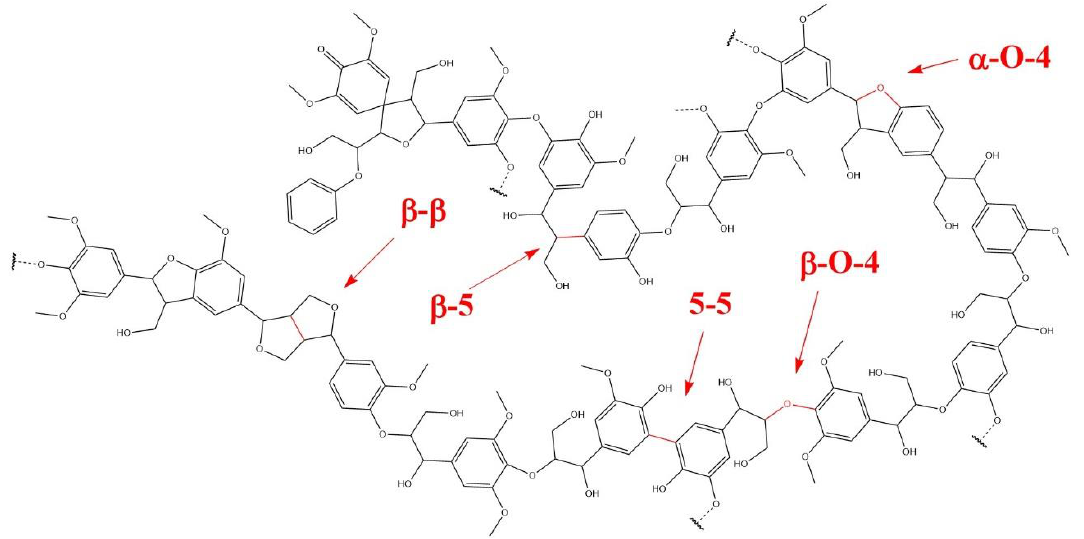
Figure 1. Main linkages in suppositional lignin structure.